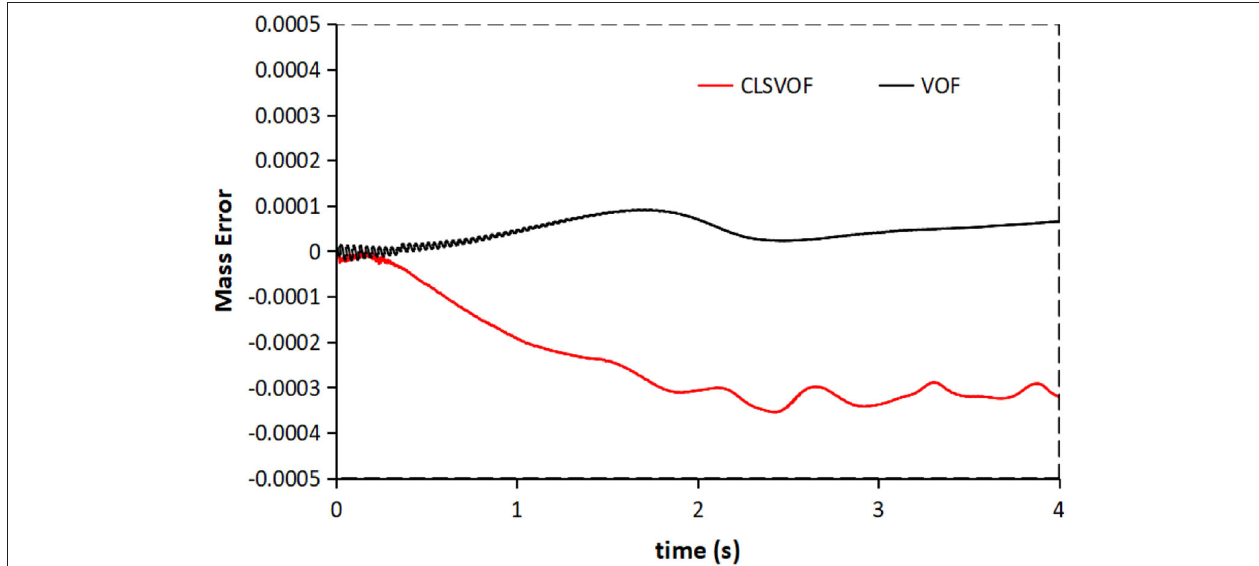
FIGURE 7 | Mass conservation against times for both methods.